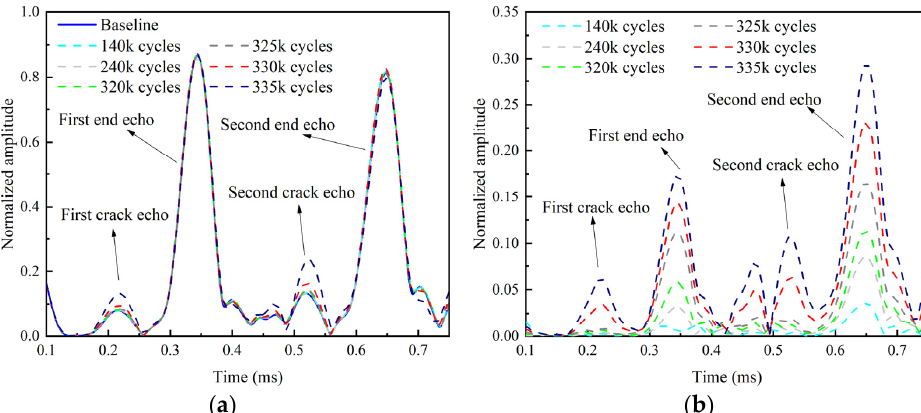
Figure 25. Envelopes of fundamental and residual echo signals after various of loading cycles. ( a ) Envelope of echo signal; ( b ) Envelope of residual echo signal.